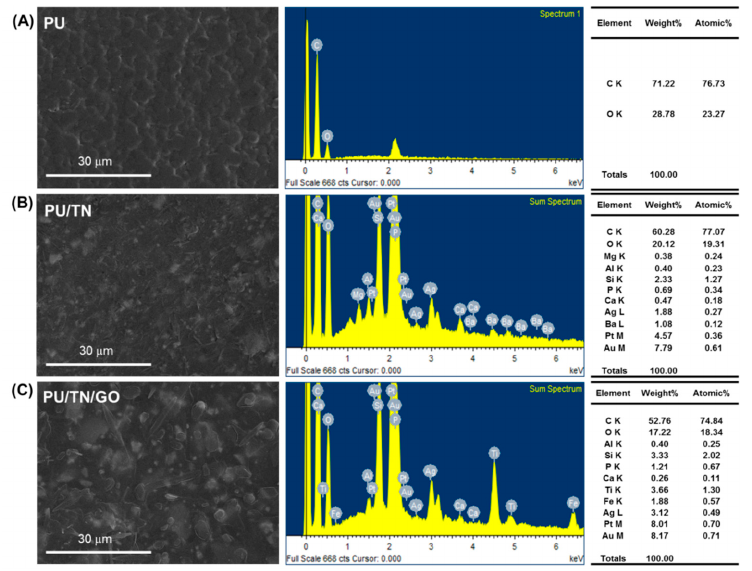
Figure 4. SEM images of cross sections and corresponding EDS peaks of ( A ) PU; ( B ) PU/TN and ( C ) PU/TN/GO.